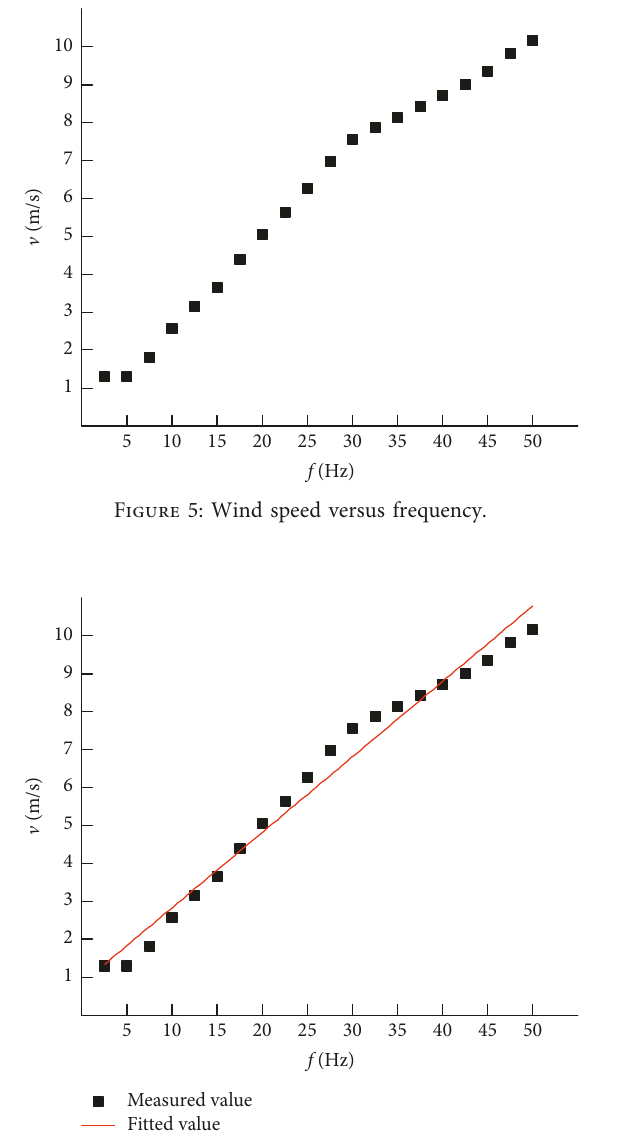
Figure 6: Fitting formula and measuring wind speed.